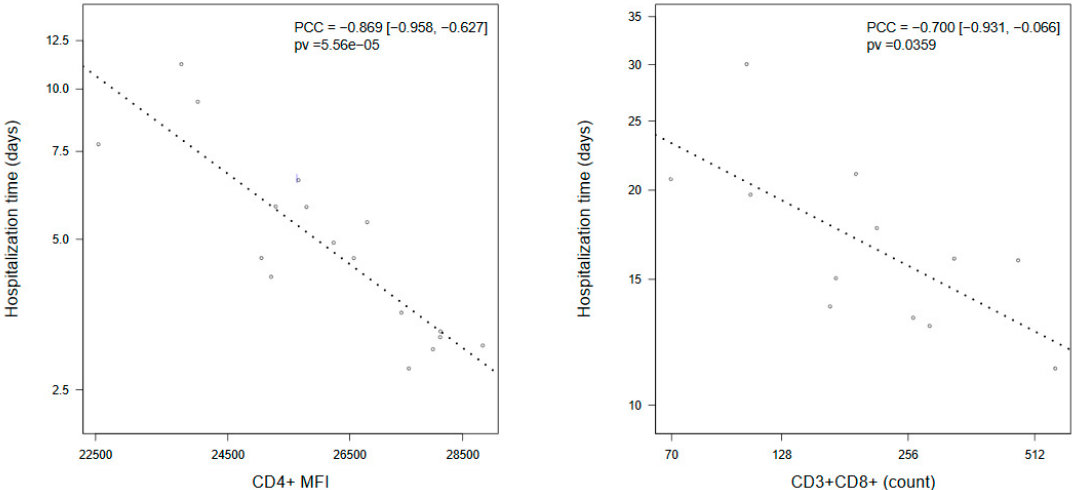
Figure 2. Dotplots showing association of stay length in hospital with: CD4 + MFI in COVID-19 patients that did not change non-critical clinical status (CD4 + MFI); and CD3 + CD8 + T cell count in patients who reached critical condition during their hospitalization (CD3 + CD8 + count). Association was assessed using a linear model controlling by age, gender, and time from symptoms onset. p -values were derived from a F-test of the linear model. Association was measured using Partial Correlation Coe ffi cients (PCC) and their 95% confidence intervals. Dot lines represent the slope estimated by the linear model. Values are displayed after a-priori correction by the rest of covariates in the